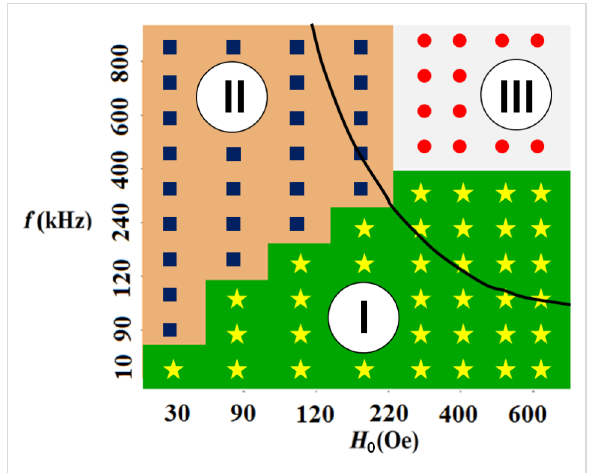
Figure 2: The domains of various magneto-dynamic modes of motion of a superparamagnetic nanoparticle in a viscous liquid depending on frequency and amplitude of the RMF. The Brezovich area [49,50] recommended for medical reasons for use in magnetic hyperthermia, fH 0 ≤ 6.25 × 10 4 kHz·Oe, is located below the black curve.